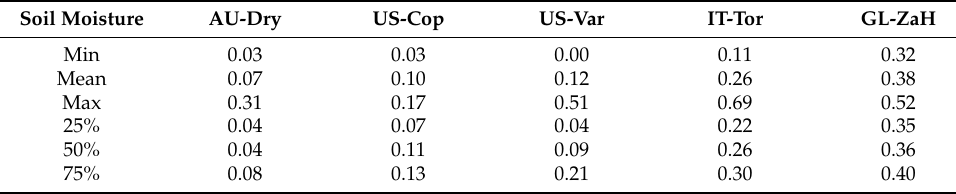
Table 5. Statistical description of the soil moisture data collected in each